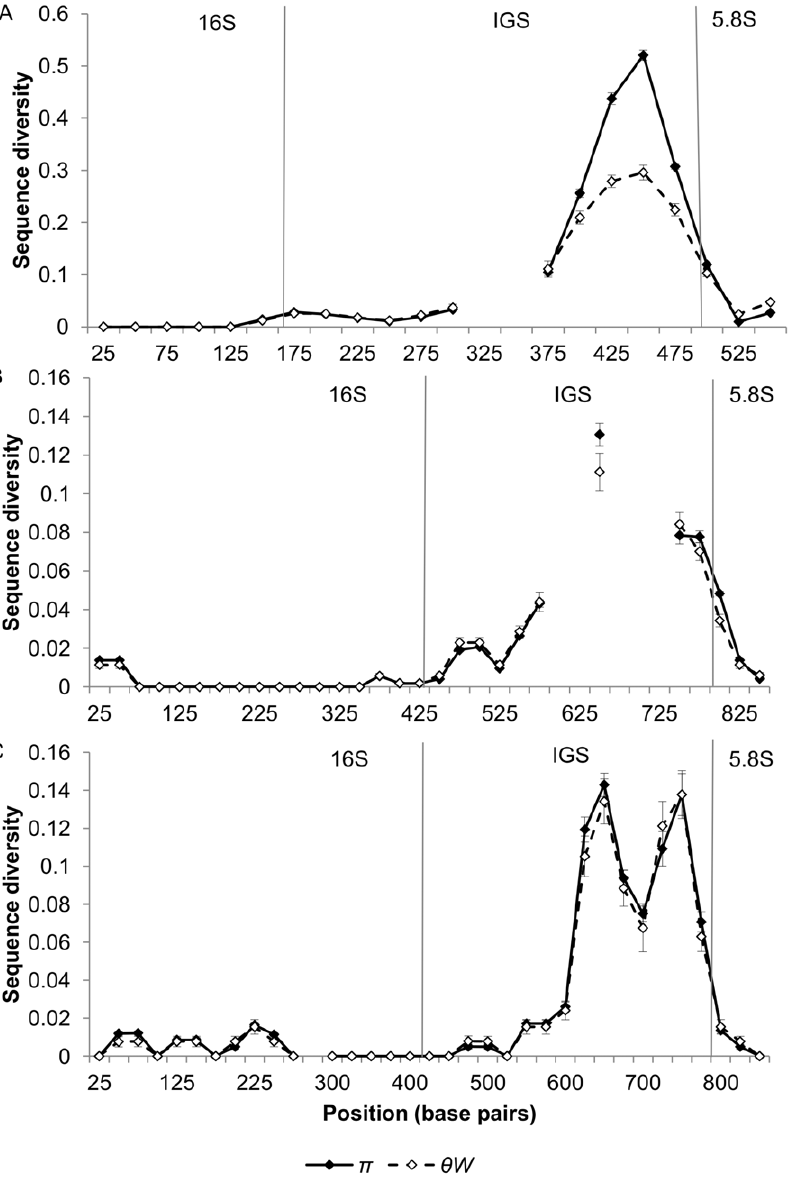
Figure 2. Sliding window analysis of nucleotide diversity in the IGS and flanking 16S and 5.8S rDNA regions of N.bombycis (Part A), N.granulosis (Part B) and V.cheracis (Part C). A sliding window of 50 base pairs is used, with an increment of 25 base pairs. Nucleotide diversity is calculated as the average heterozygosity per site ( p ) and the average number of nucleotide differences per site ( h W ). Error bars show the standard error for each window. Regions in which sequences could not be aligned due to multiple insertions and deletions are indicated by missing data (breaks in the line).